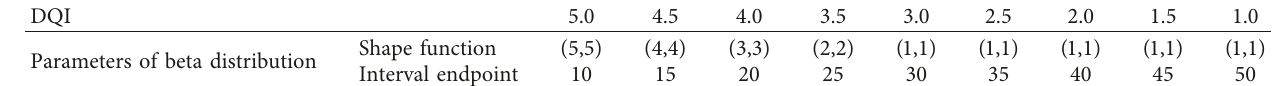
Table 2: Converting matrix of probability density function